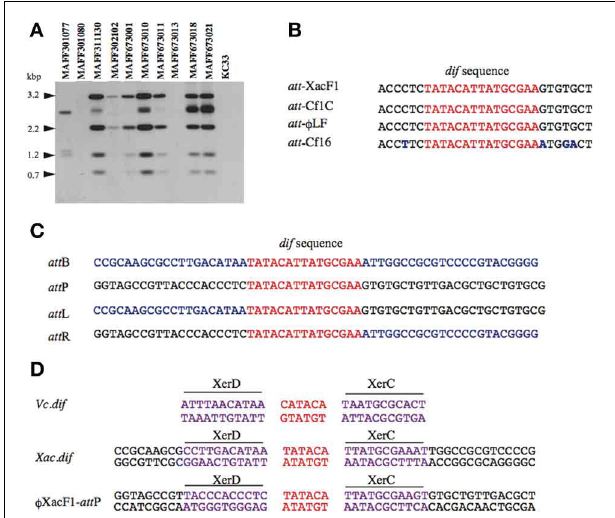
FIGURE 3 | Site specific integration of XacF1 DNA into the chromosome of Xac . (A) Southern blot hybridization analysis showing integration of the XacF1 phage into Xac host chromosomes. Genomic DNA of X. axonopodis pv. citri strains was digested with Hin cII and hybridized with a probe (the entire XacF1 phage genomic DNA digested with Eco RI). (B) The att P sequence indicated for XacF1 is compared with att P sequences (putative in some cases) of filamentous phages, including Cf1c (accession no. NC_001396), Cf16-v1 (M23621), and Lf (X70328) phages of X. campestris . The dif core sequences are shown in red. Changed nucleotides are shown in blue. (C) Alignment of att sequences in the XacF1 integration system. The att L and att R sequences were determined for a lysogenic strain newly established with Xac MAFF673010 infected with XacF1. The att B sequence ( dif ) of X. axonopodis pv. citri 306 was obtained from the genome database (accession no. AE008923.1, Jalan et al., 2011). Common 15 bases are shown in red and chromosomal sequences are in blue. (D) Putative XerC, XerD binding sites of the XacF1 system are compared with those of Vibrio cholerae dif 1.